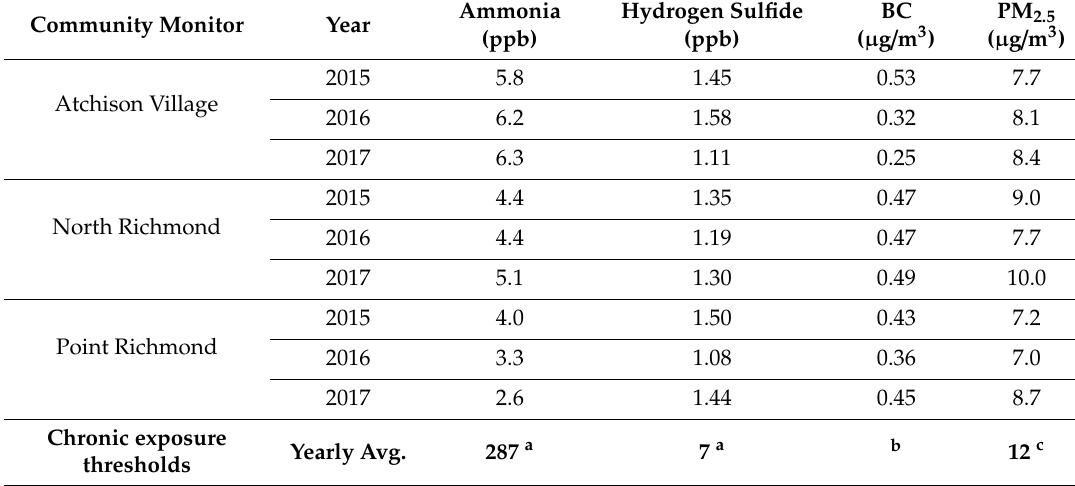
Table 2. Annual average concentrations of hydrogen sulfide, ammonia, BC and PM 2.5 at the three community monitoring sites compared to relevant exposure standards.